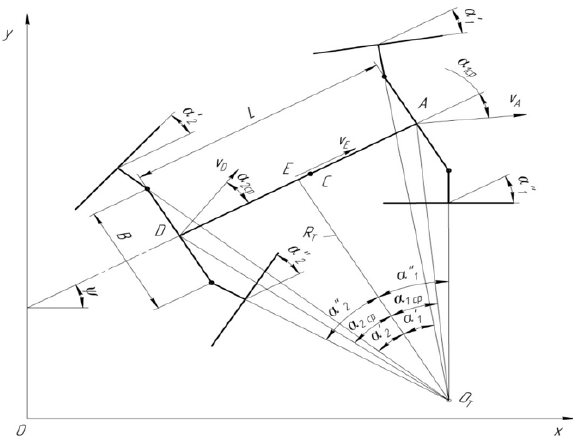
Fig. 1. Analytical model of wheeled vehicle with all steered wheels